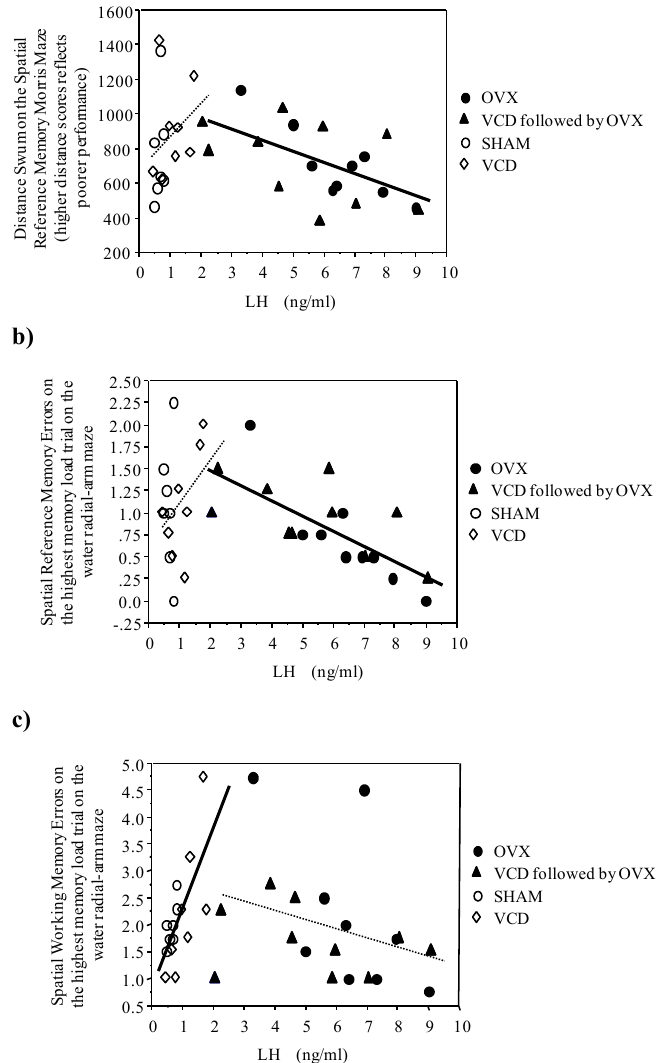
Figure 8. Circulating LH levels show a curvilinear relationship with memory scores [87]. Regression analysis indicated that in animals without ovaries (Ovx and VCD-Ovx), higher LH was associated with better reference memory for the a) Morris maze and, b) water radial-arm maze. As shown in c), in animals with ovaries (SHAM and VCD), higher LH was associated with worse working memory; indeed, higher LH was associated with more water radial-arm maze working memory errors. Graphically, the significant regression coefficients for these analyses are shown as solid lines; the dashed lines of the other groups are shown for comparison purposes to aid